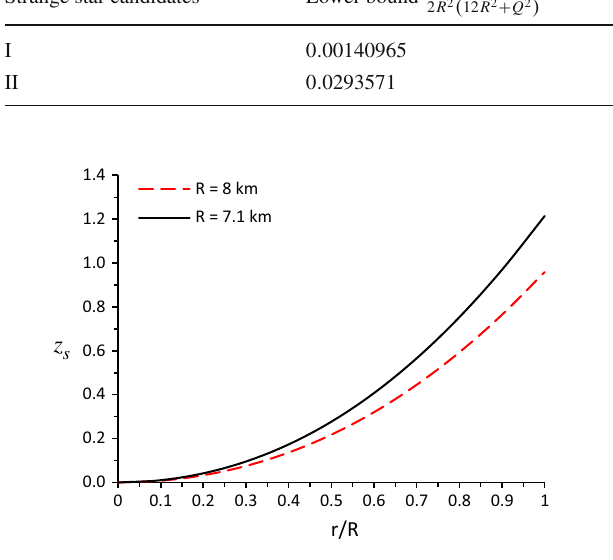
Table 3 The lower and upper bounds for the mass–radius ratio and the mass–radius relation for Strange star candidates Strange star candidates